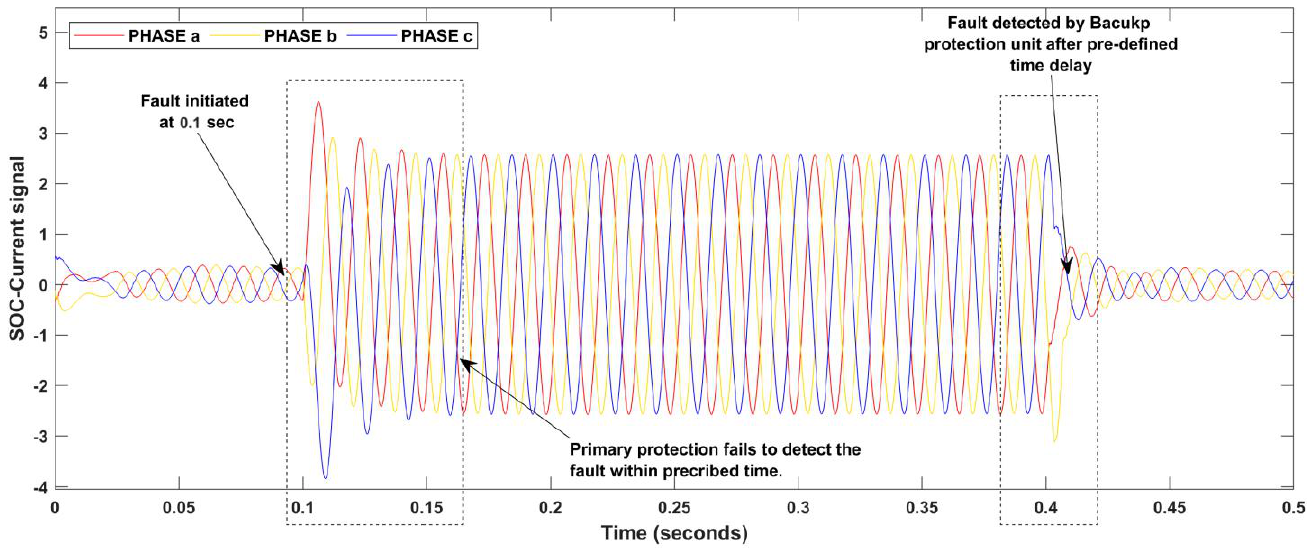
Figure 5. Backup protection feature case study.